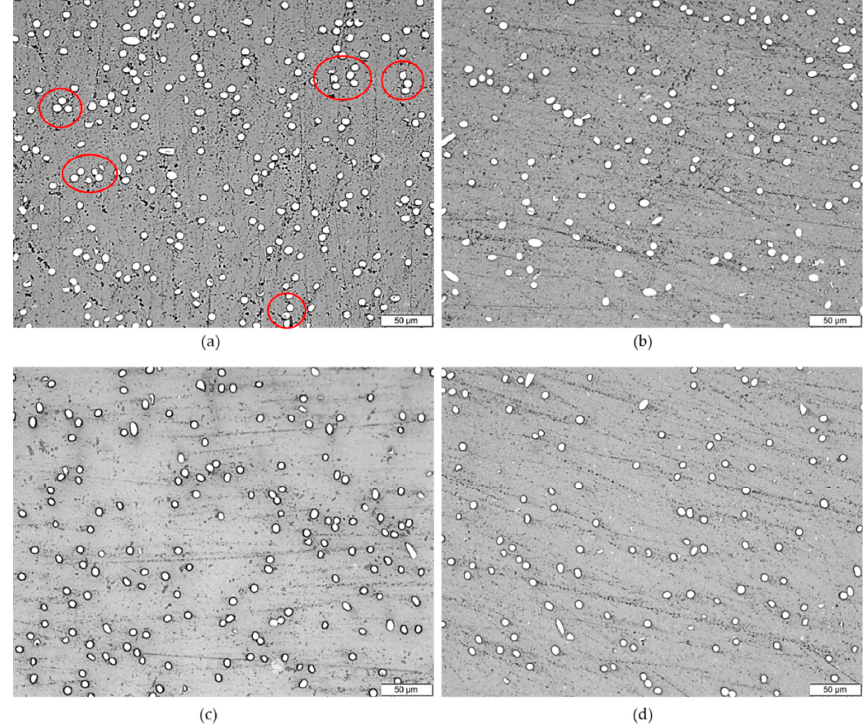
Figure 3. Optical microscope images of cross-section surfaces of ( a ) PP / 15SCF, ( b ) PP / 10SCF / 5 nTiO 2 , ( c ) PP / 10SCF / 5GNP, and ( d ) PP / 10SCF / 2.5GNP / 2.5nTiO 2 composites.